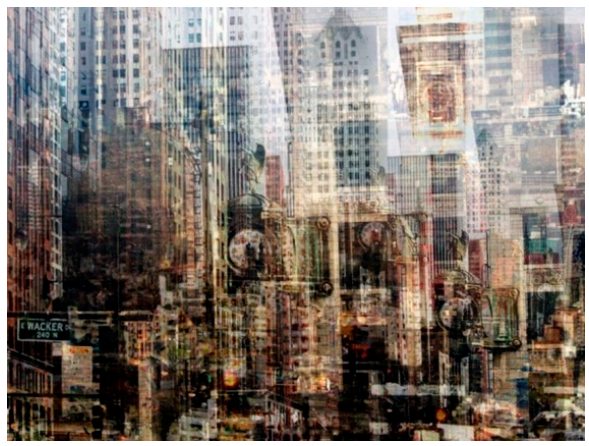
Figure 8. Image from: “SOCIAL_SYNTHESIZER—cityscapes”by Aetherbits (Cádiz, Clelland, Lelong). Courtesy by authors. Source: